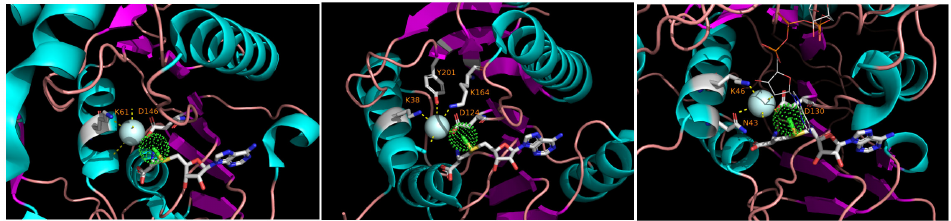
Figure 2. Bound water molecules in the active centers of diverse RrmJ-like methyltransferases. The cyan sphere represents water, and the green dotted sphere represents the methyl group of the bound S-adenosylmenthionine rendered as licorice sticks). The side chains of the residues that ligate the water molecule are shown and marked; the numbering is from the beginning of a pdb entry, not from the beginning of the virus (poly)protein as in Figure 1. ( Left ), NS5 methyltransferase of Dengue virus 3 (pdb 3P97); center, methyltransferase RmlE of E. coli (pdb 1EIZ); ( Right ), coronavirus methyltransferase Nsp16 (pdb 6WKS).